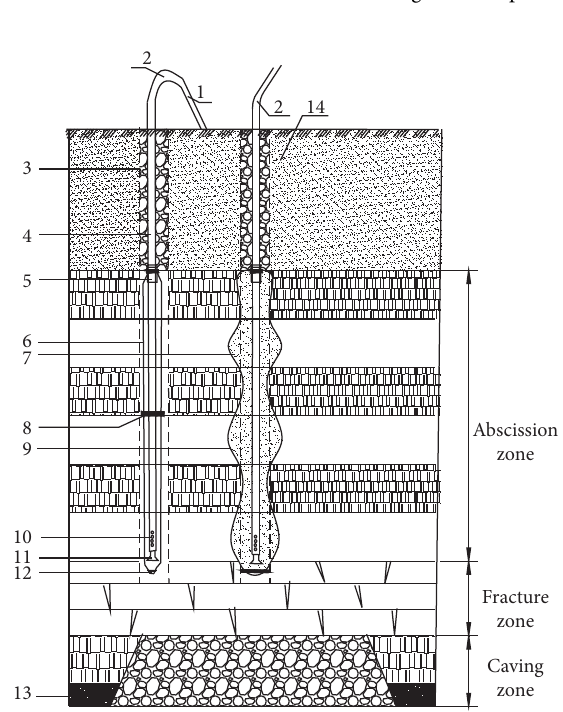
Figure 9: Diagram of separation layer plane and drilling hole oblique.